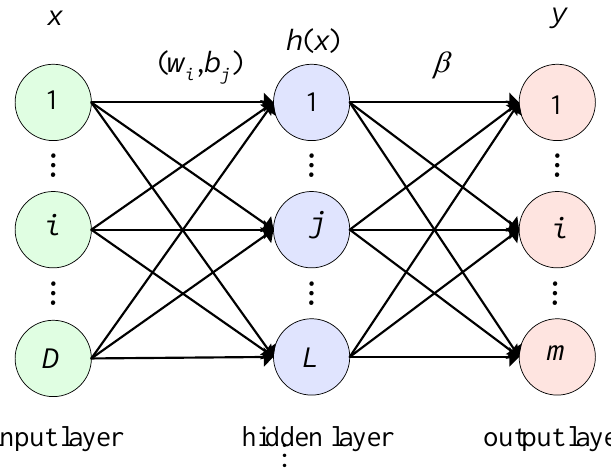
Figure 1. The architecture of ELM.